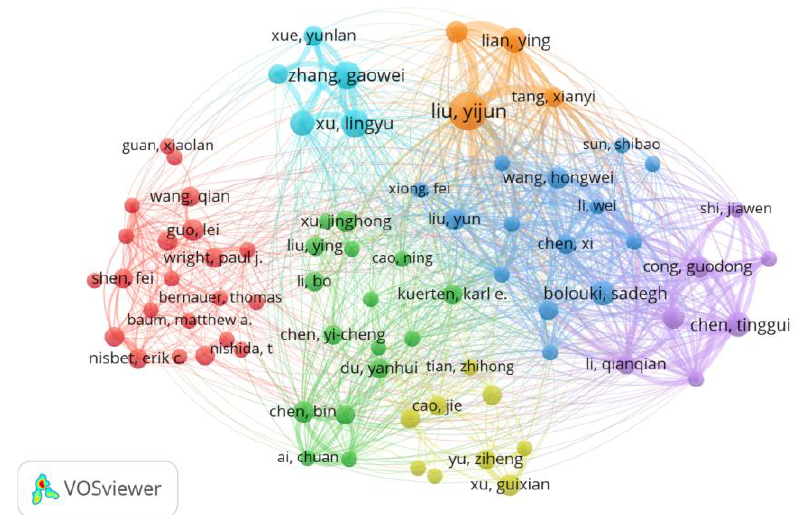
Figure 8. Cooperation authors in NPO studies.